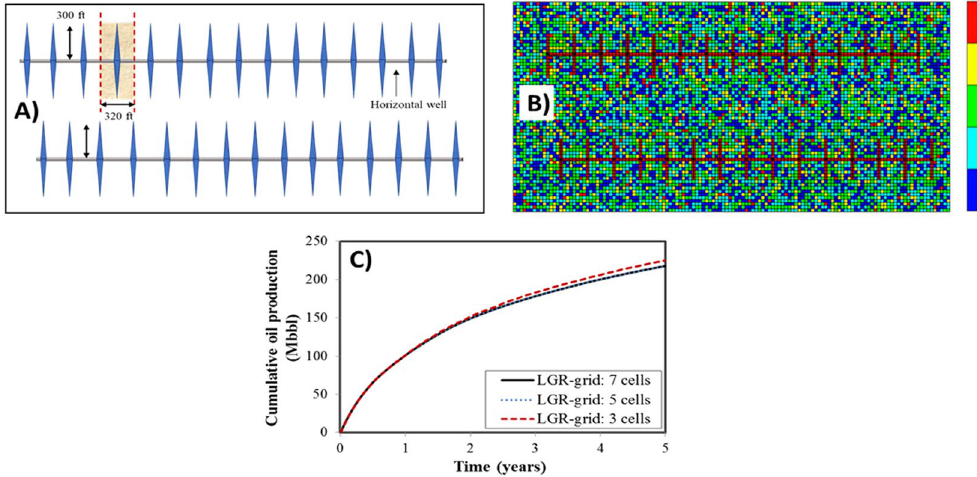
Figure 7. Schematic reservoir simulation model with the pore size distribution and the effect of LGR-grid sizes. ( A ) Schematic reservoir simulation model. ( B ) Pore size distribution (Color bars of 1–5 represent five different regions). ( C ) Effect of LGR-grid sizes on the well performance.